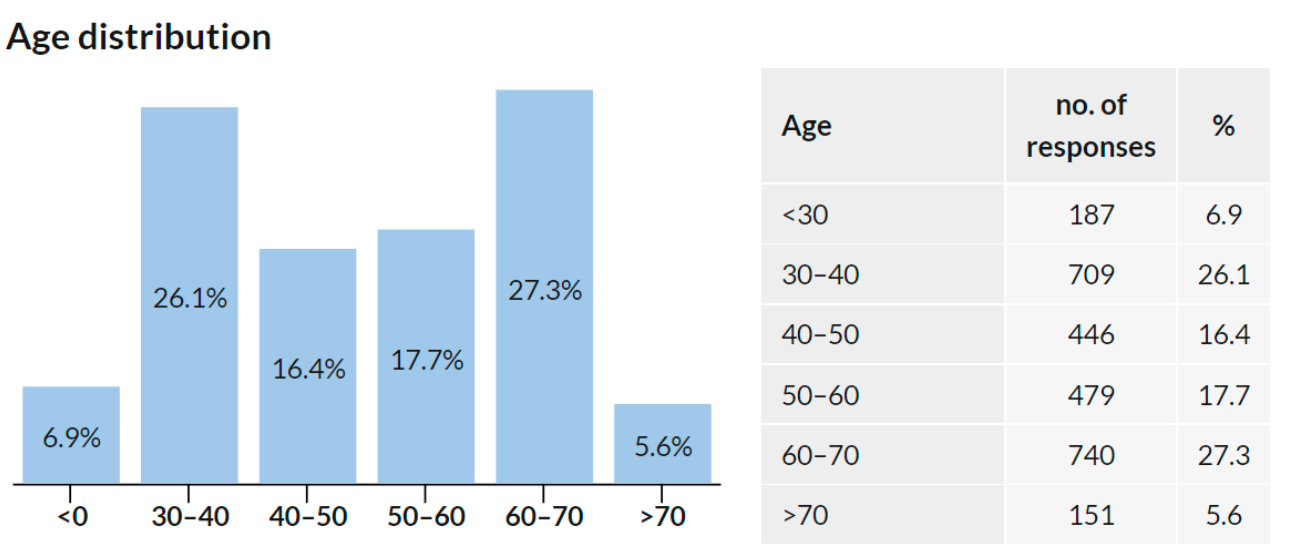
Figure 2. Sex distribution of the study participants.